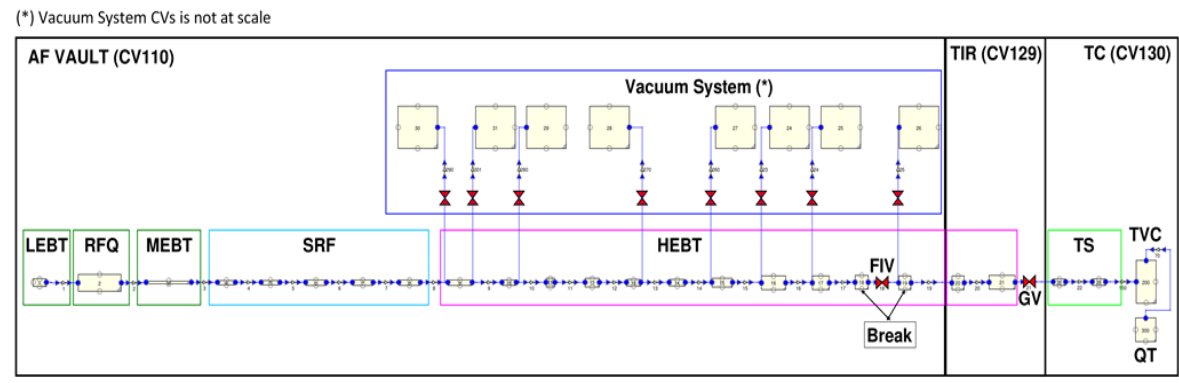
Figure 3. MELCOR model for accelerator systems events .